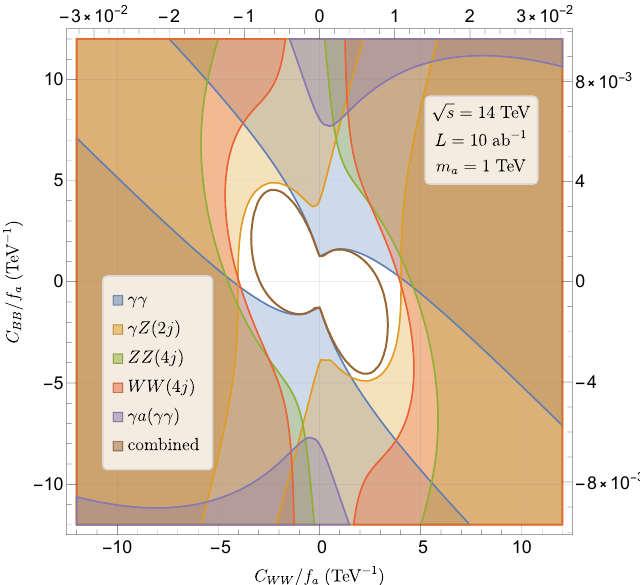
Figure 11 . Projected 2 σ constraint contours in the C BB /f a − C WW /f a plane, for a 1 -TeV ALP at a 14 -TeV muon collider with L = 10 ab − 1 , assuming C BW = 0 . Detectable regions of different search channels are shaded with various colors. The solid brown butterfly-shaped curve around the center is the combined 2 σ exclusion contour. Note that the bottom and left axes indicate values of the ALP couplings defined in eq. (2.1), while the top and right axes indicate values of these couplings absorbing the gauge couplings and loop factors following the convention in ref.